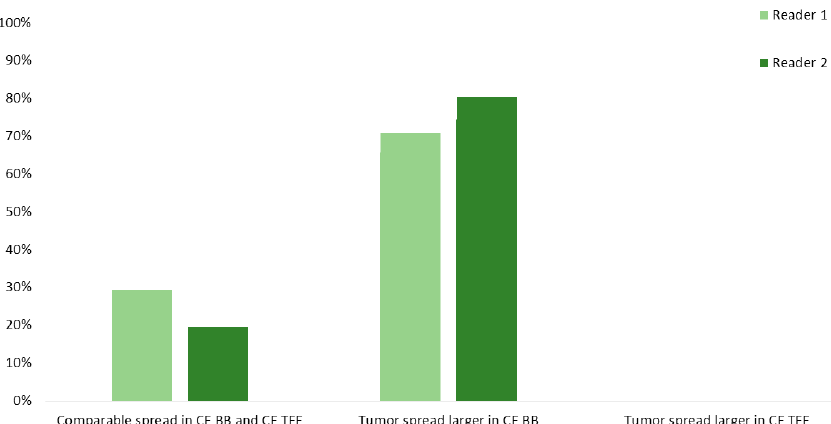
Figure 3. Spread of the contrast-enhancing tumor residuals into adjacent brain parenchyma for contrast-enhanced (CE) turbo field-echo (TFE) and Black Blood (BB) sequences derived from intraoperative magnetic resonance imaging (iMRI). Evaluations were performed by two readers (R1 and R2).